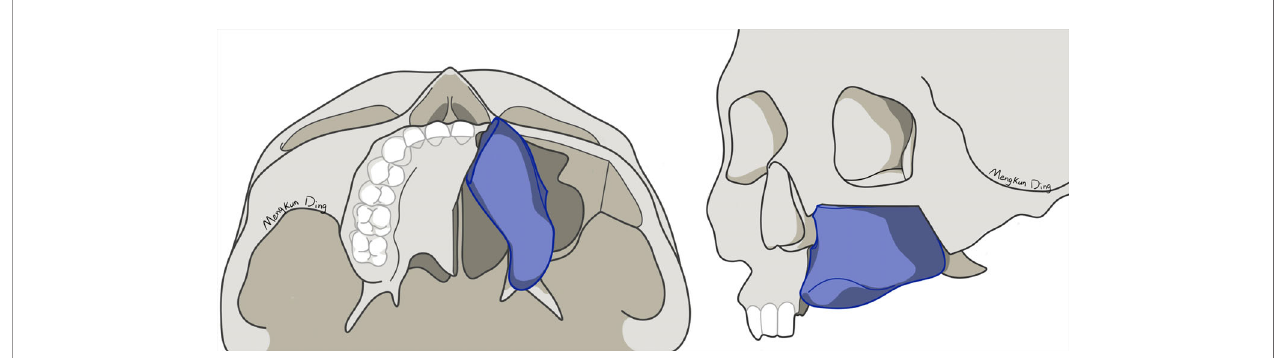
FIGURE 4 | Shaping and reconstruction strategy for Brown class II defects.